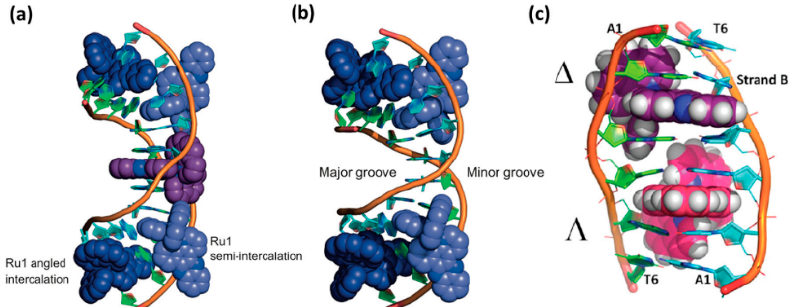
Figure 5. ( a ) Crystal structure of Δ -[Ru(phen) 2 dppz] 2+ with oligonucleotide d(CCGGTACCGG) 2 . ( b ) Crystal structure of Λ -[Ru(phen) 2 dppz] 2+ with oligonucleotide d(CCGGATCCGG) 2 . The C1C2/G9G10 intercalated Ru complex is in dark blue, and the C1C2/G9G10 semi-intercalated Ru complex is in light blue. The central AT/TA intercalated Ru complex (purple) in ( a ) is treated as a whole complex of 0.5 occupancy per oligonucleotide strand. Reprinted with permission from the authors of [27]. Copyright © 2012, Springer Nature. ( c ) Crystal structure of rac-[Ru(phen) 2 dppz] 2+ with oligonucleotide d(ATGCAT) 2 . The Δ -[Ru(phen) 2 dppz] 2+ is in purple, and the Λ -[Ru(phen) 2 dppz] 2+ is in pink. Reprinted with permission from the authors of [52]. Copyright © 2013, American Chemical Society.